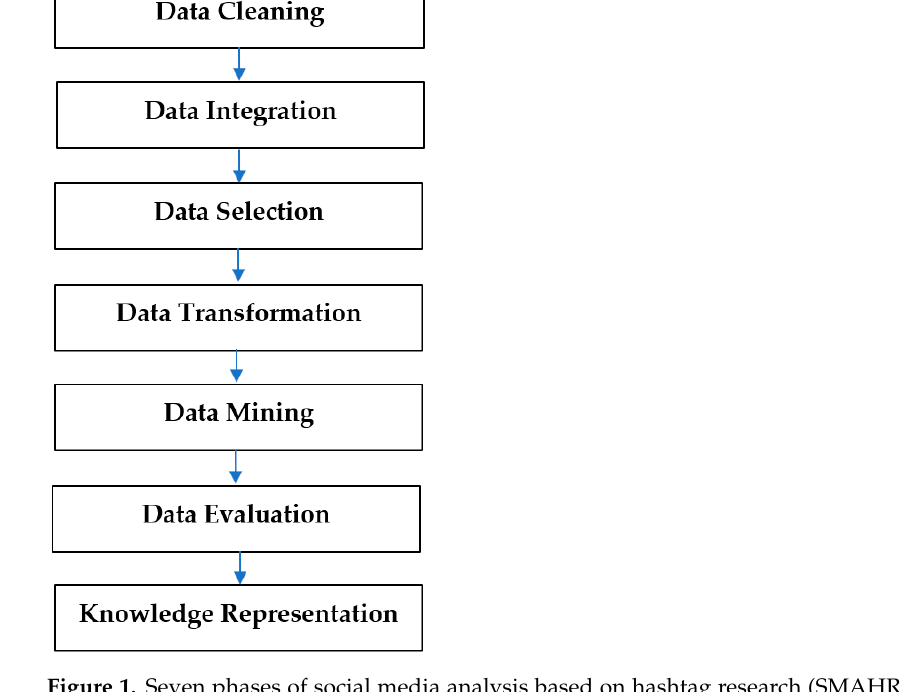
Figure 1. Seven phases of social media analysis based on hashtag research (SMAHR) framework process. Source: Own processing.